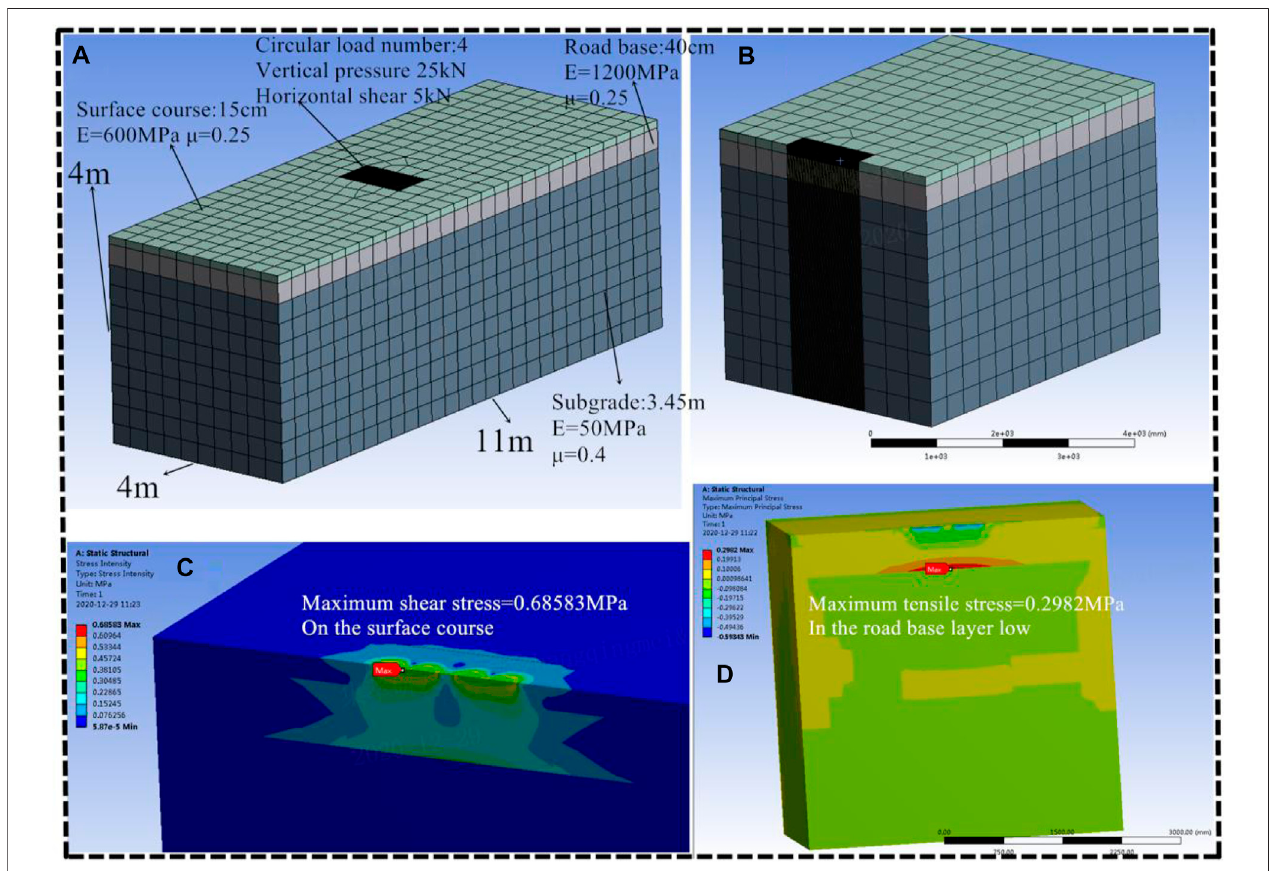
FIGURE 7 | Finite element analysis: (A) mesh dividing; (B) cross section; (C) stress intensity; and (D) maximum principal stress.